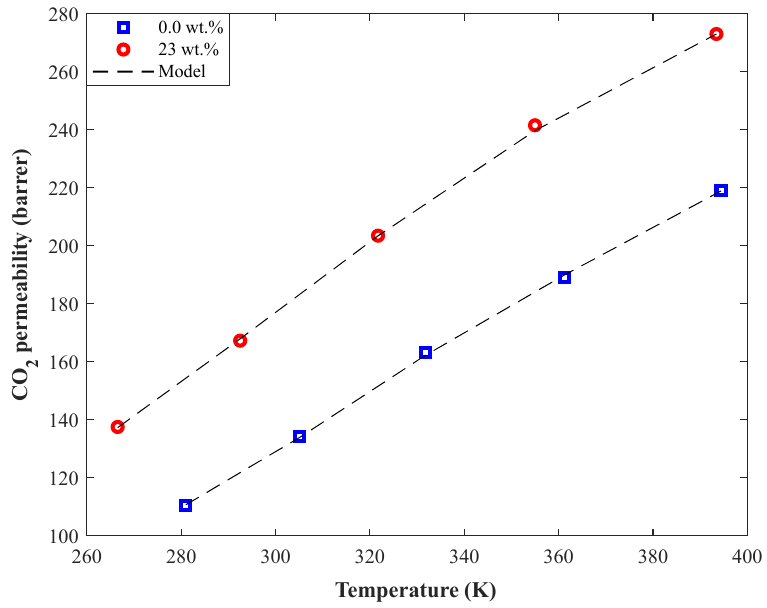
Figure 7. The effect of temperature on the CO 2 permeability in pure Pebax-1657 and Pebax- 1657/SAPO-34 MMM (0.7 MPa).